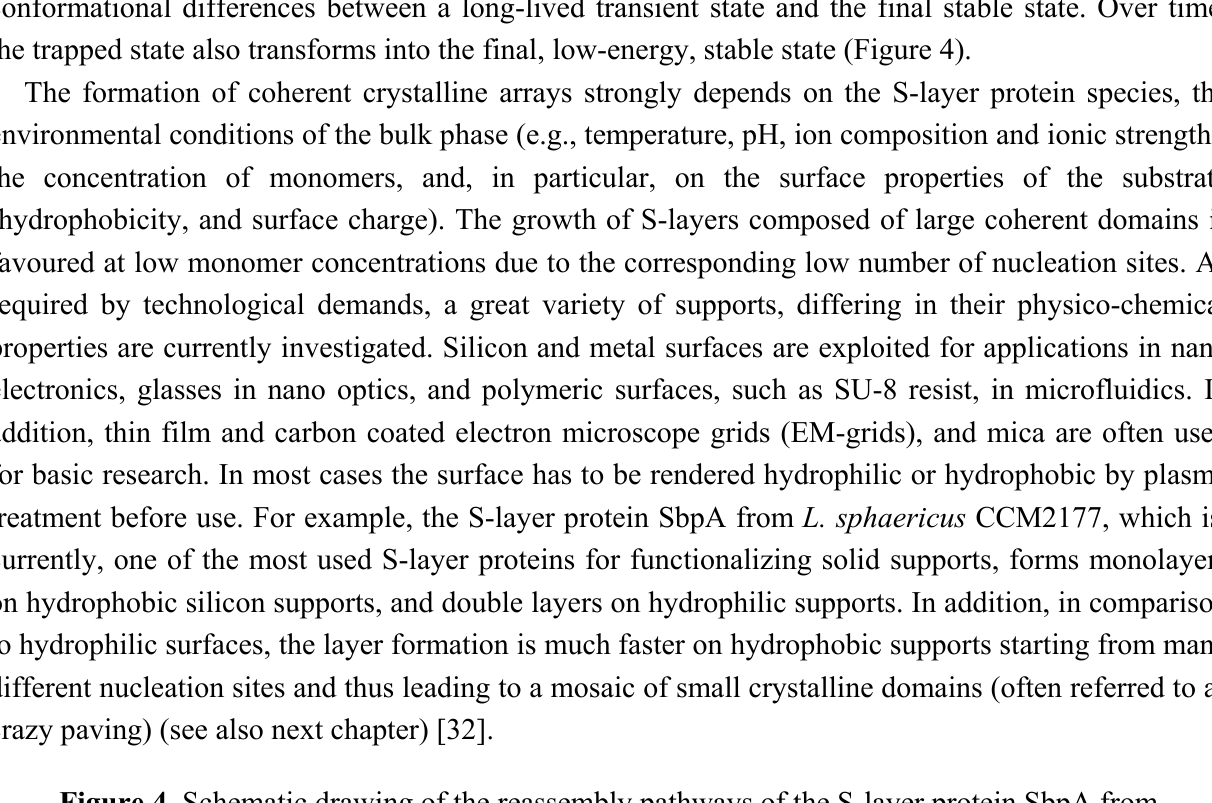
Figure 4 . Schematic drawing of the reassembly pathways of the S-layer protein SbpA from L. sphaericus on solid surfaces (drawn after description in reference [64]). Inset: AFM image of the S-layer of L. sphaericus